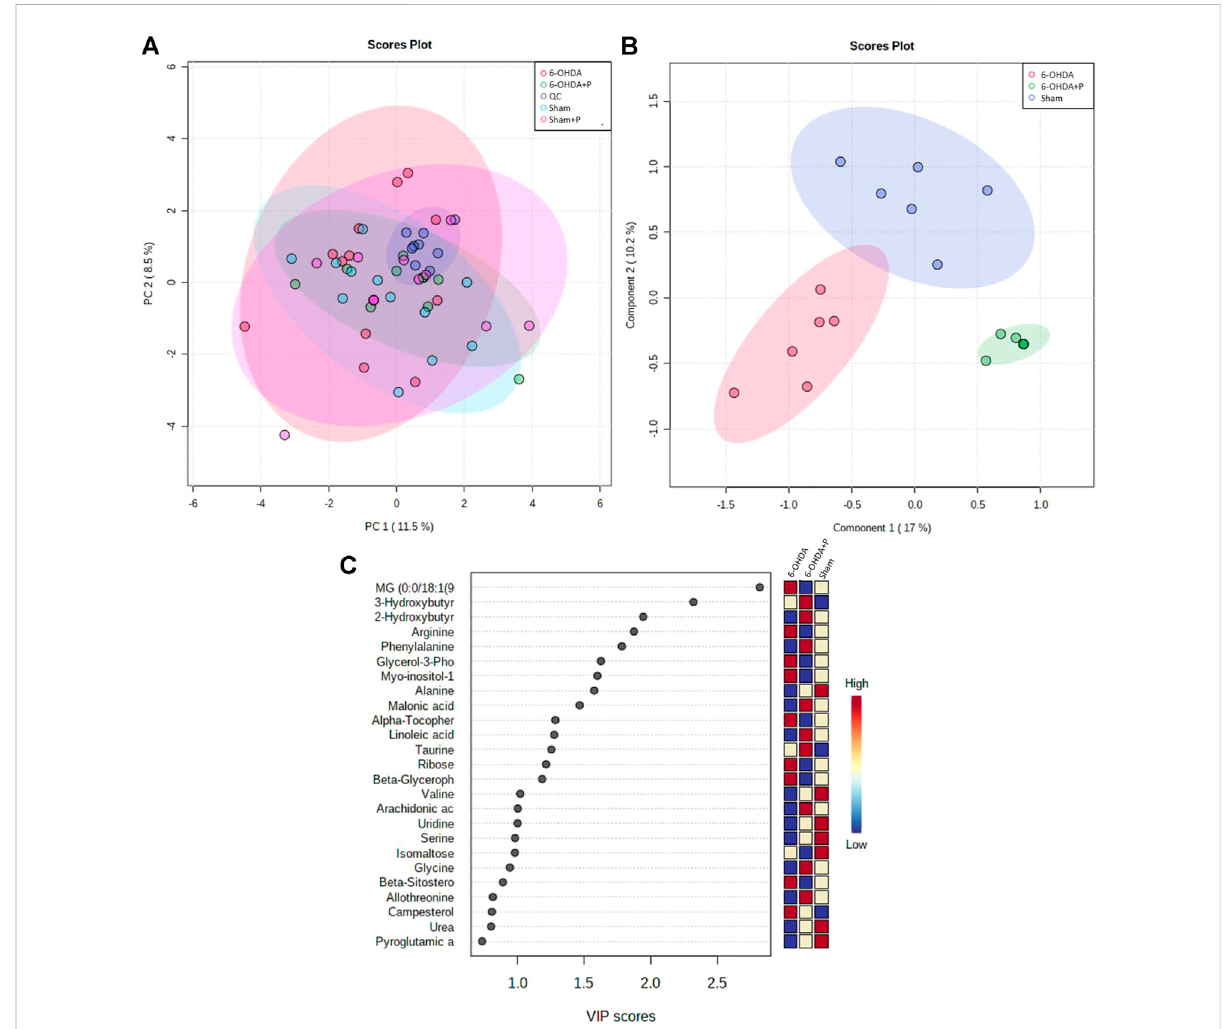
FIGURE 6 Majormetabolitespresentinratheart tissue.Multivariate statistical analysisbetween the6-OHDA,6-OHDA + PandShamgroups andthemain metabolitesfound. (A) PCAanalysistoinvestigatetheinterrelationshipsbetweenthemostimportantvariables(PC1,maincomponentone;PC2,main component two) found and to verify the reliability of the data between the groups. (B) PLS plotting with the separation of groups in relation to the metabolites found. (C) List of the main metabolites identi fi ed in the heart of animals, shown as a VIP score. The colored boxes on the right indicate the relative concentrations of the corresponding metabolite for the control animals and the 6-OHDA-lesioned animals that consumed propolis or not.